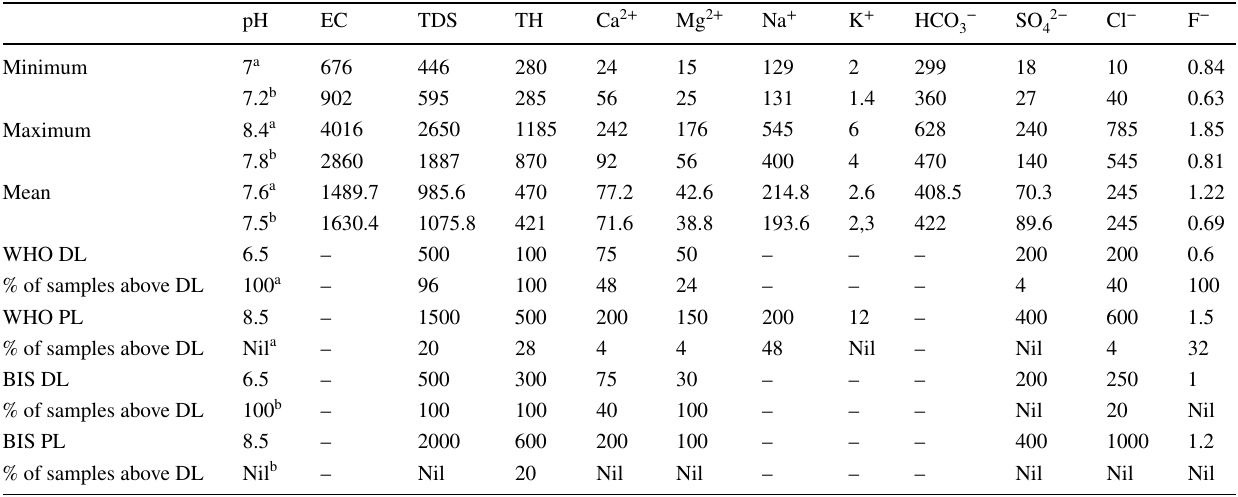
Table 3 Minimum, maximum and mean of groundwater and surface water samples from the study area and its analytical data and comparison with the WHO and BIS standards for drinking purposes